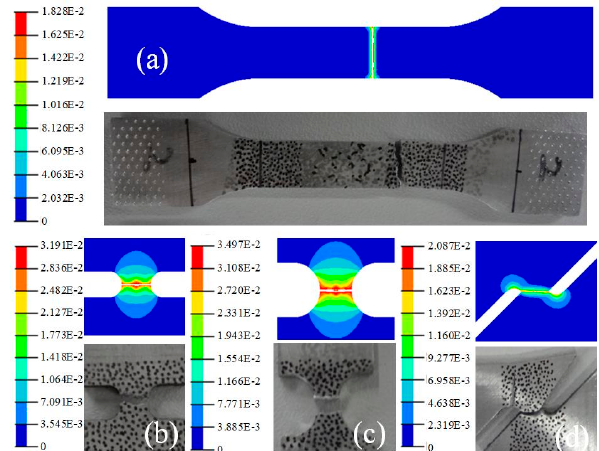
Figure 6. Fracture mode for 7003Al-T6 aluminum alloy for ( a ) smooth tensile test, ( b ) pure shear test, ( c ) tensile and shear test, ( d ) notched test for notched radii 5 mm, ( e ) notched test for notched radii 10 mm, ( f ) notched test for notched radii 15 mm and ( g ) notched test for notched radii 20 mm. Hereinafter, the numerical fracture mode is in plastic strain contour.